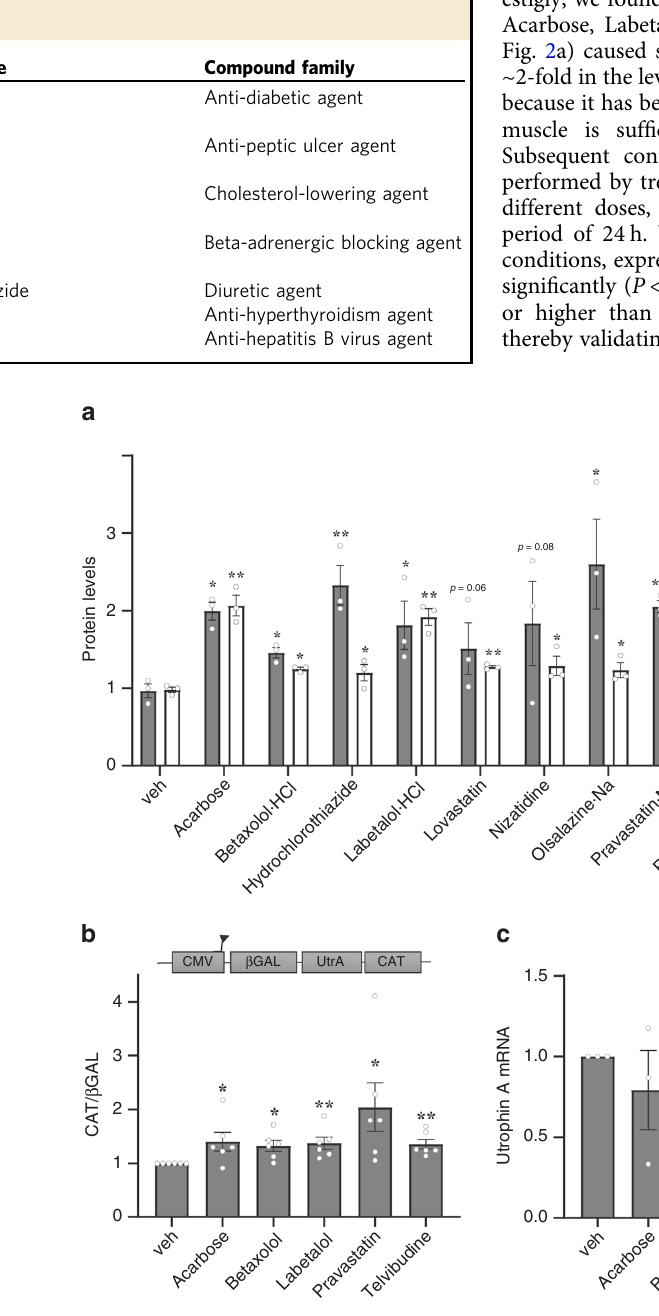
Fig. 2 Pharmacological activation of eEF1A2 and utrophin A by FDA-approved drugs. a An ELISA-based high-throughput drug screen was performed by treating C2C12 cells with 262 different FDA-approved drugs or vehicle control for 24 hours. Quanti fi cation of eEF1A2 and utrophin A protein levels from the 11 FDA-approved drugs considered as leads. A drug is considered a hit based on its ability to increase eEF1A2 and utrophin A protein levels over vehicle control ( N = 3). b Activation of the utrophin 5 ′ UTR IRES reporter construct by 24-h treatment of FDA-approved drugs in C2C12 cells. The treated muscle cell samples were subjected to a reporter assay to determine CAT and β -GAL activity representative of IRES activity. CAT activation was normalized to β -GAL and each drug activation was normalized to vehicle control ( N = 6). c Relative quanti fi cation of utrophin A mRNA levels in C2C12 treated cells, determined by qRT-PCR ( N = 3). The values were normalized to 18S mRNA levels. Error bars represent SEM. * P < 0.05, ** P < 0.01, versus vehicle control. One-way ANOVA and Bonferroni post-hoc test was performed to determine statistical differences. Source data are provided as a Source Data fi